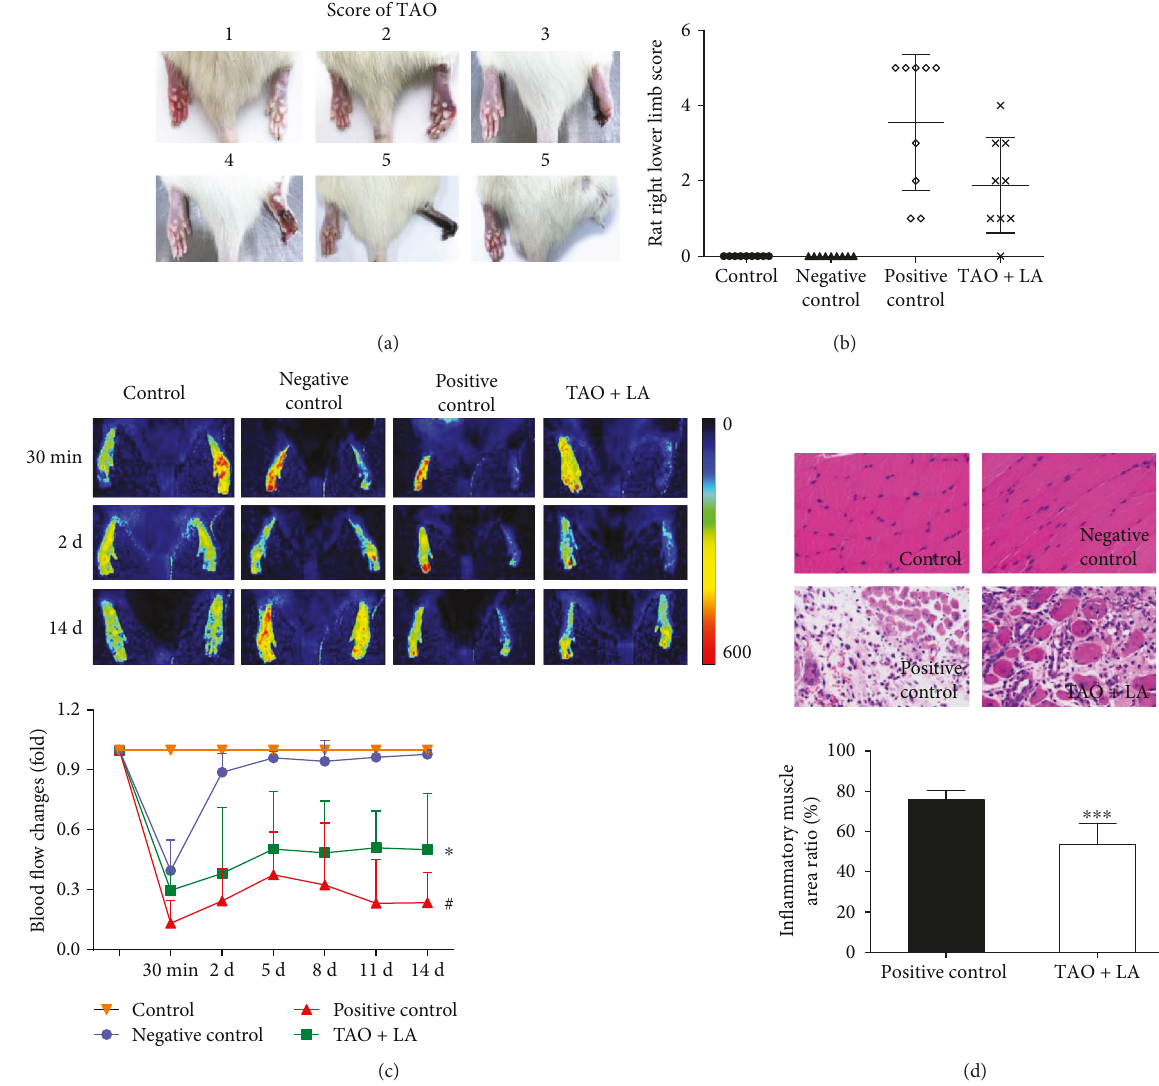
Figure 4: LA reduced the damage to the rats ’ lower limbs in the TAO model. A right lower extremity arterial injection of sodium laurate 10mg/mL 0.2mL was used in the positive control group, and 0.9% physiological saline 0.2mL femoral artery injection was used in the negative control group. The e ff ect of the operation was con fi rmed using laser speckle fl owmetry 30 min after surgery. The rats in the control group and positive and negative control groups were given the adjuvant (CMC-Na) only, whereas the LA group received 20mg/kg/d for 2 weeks, which started to gavage 2 d before surgery. One week after surgery, various degrees of gangrene were observed in the rats ’ lower right limbs, as shown in (a). The score of the right lower limb of each group was assessed according to the TAO model score standard (b). The blood fl ow of the lower limbs in each group was measured using laser speckle fl owmetry (c). In fl ammatory necrosis of the right leg muscle was observed using HE-stained slices (400 ∗ ) (d). Data are presented as mean ± SD . # p < 0 05 versus negative control group; ∗ p < 0 05 and ∗∗∗ p < 0 001 versus positive control